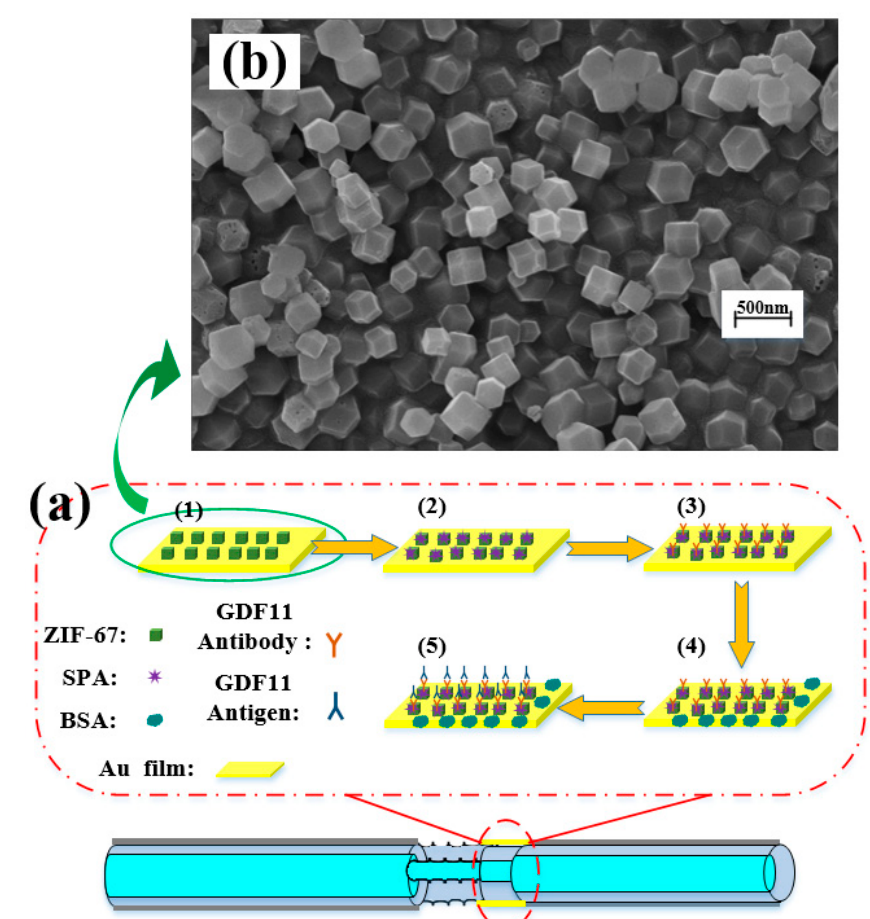
Figure 5. Schematic diagram of the surface functionalization of the sensing probe: ( a ) surface modification process of the fiber SPR biosensor; ( b ) scanning electron microscope photo after ZIF-67 modification.